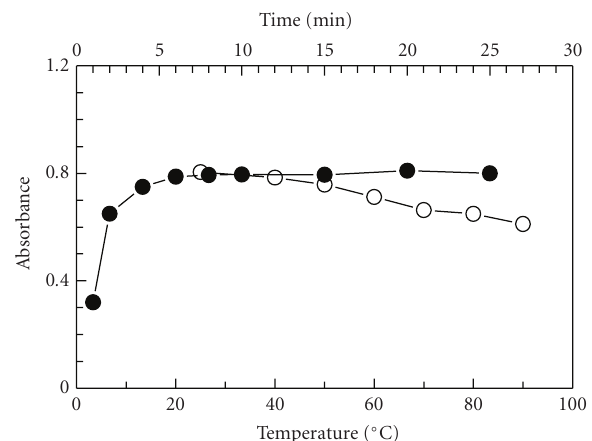
Figure 4: E ff ect of temperature ( ◦ ) and time ( • ) on the reaction of PRX with NQS. PRX (40 μ gmL − 1 ): 1 mL; Clark and Lubs bu ff er solution (pH 9): 1mL; NQS (0.5%, w/v):